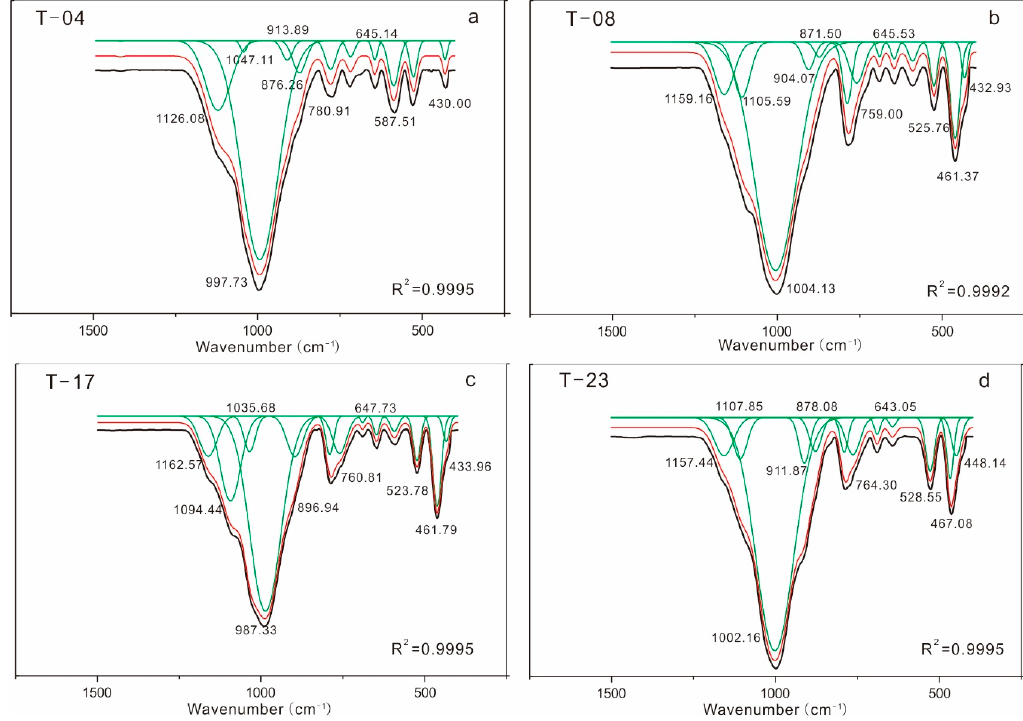
Figure 5. Decomposition of the MIR bands in the low-frequency area of four samples ( a ) T-04, ( b ) T-08, ( c ) T-17, and ( d ) T-23. Black line: experimental; green line: fit and diagnostic bands. Table 2. Assignment of the MIR absorptions in former studies.